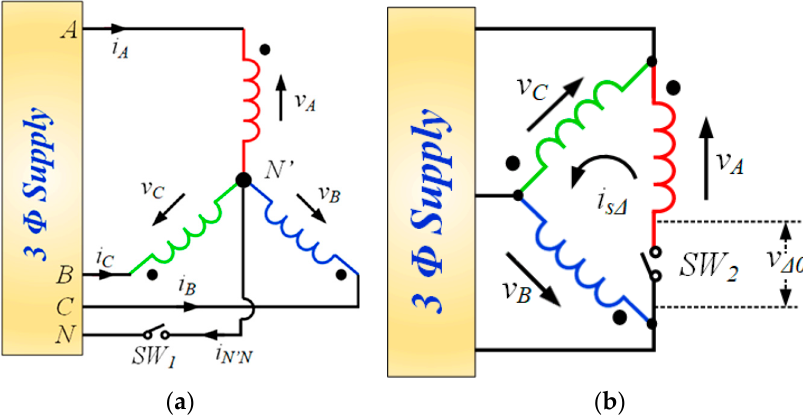
Figure 15. Presence of 3rd harmonic current in the ( a ) star-connected primary windings and ( b ) delta-connected primary windings.